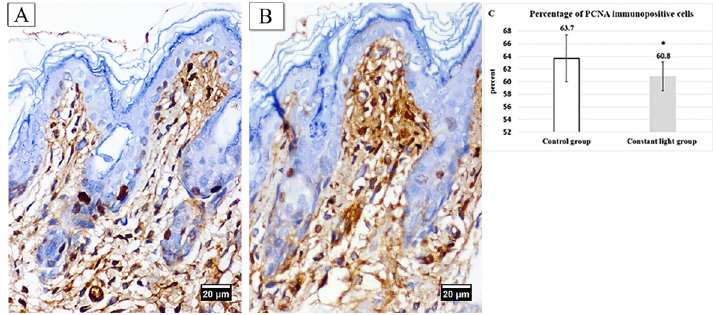
Figure 4. Immunohistochemical staining for the PCNA of dorsal skin of neonate rabbits ( (cid:1) 400, scale bar 20 m m). A , Control group showed many positive immunoreactive nuclei of stratum basale. B , Constant light group showed less positive immunoreactive nuclei of stratum basale. C , Means ± SD of percentage of PCNA immunopositive cells in stratum basale. *P o 0.05 vs control